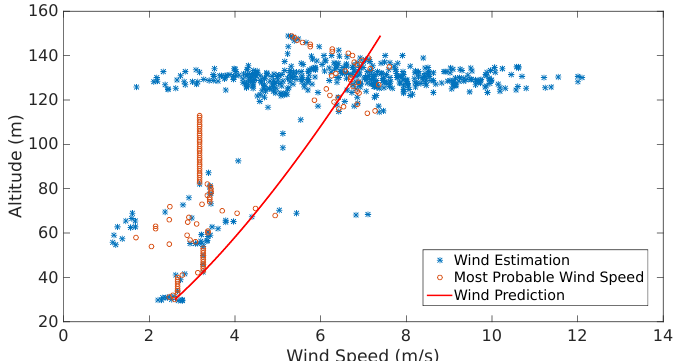
Figure 18. Estimation, most probable wind speeds and last wind prediction generated throughout the flight depicted in Figure 14c.